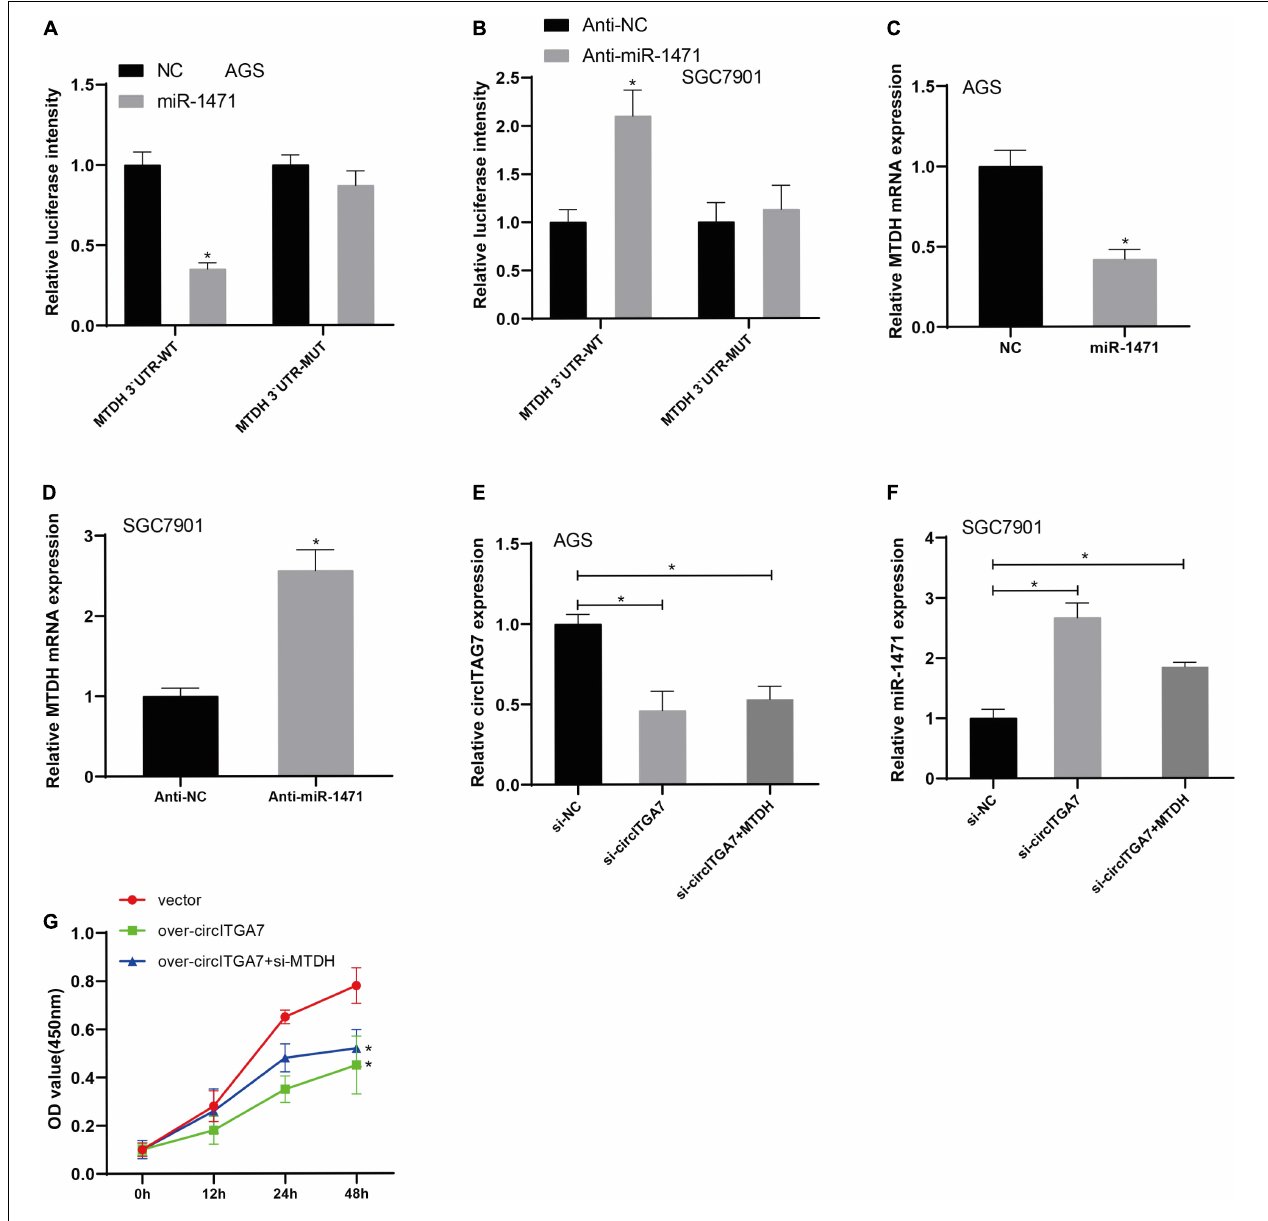
FIGURE 7 | MTDH targeted by miR-1471 reversed the effect of circITGA7. (A) The luciferase activity driven by MTDH 3 (cid:48) UTR-WT in AGS cells was remarkably reduced by overexpressed miR-1471 * P < 0.05. (B) The luciferase activity driven by MTDH 3 (cid:48) UTR-WT in SGC7901 cells was remarkably enhanced by lowly expressed miR-1471 * P < 0.05. (C) Decreased MTDH expression in AGS cells transfected with miR-1471. * P < 0.05. (D) Increased MTDH expression in SGC7901 cells transfected with anti– miR-1471. * P < 0.05. (E) MTDH partially reversed the downregulation of circITGA7 in AGS cell transfected with si-circITGA7 * P < 0.05. (F) MTDH partially reversed the upregulation of miR-1417 in SGC7901 cell transfected with si-circITGA7 * P < 0.05. (G) MTDH partially reverse the decreased cell proliferation activity by circITGA7 overexpression * P <